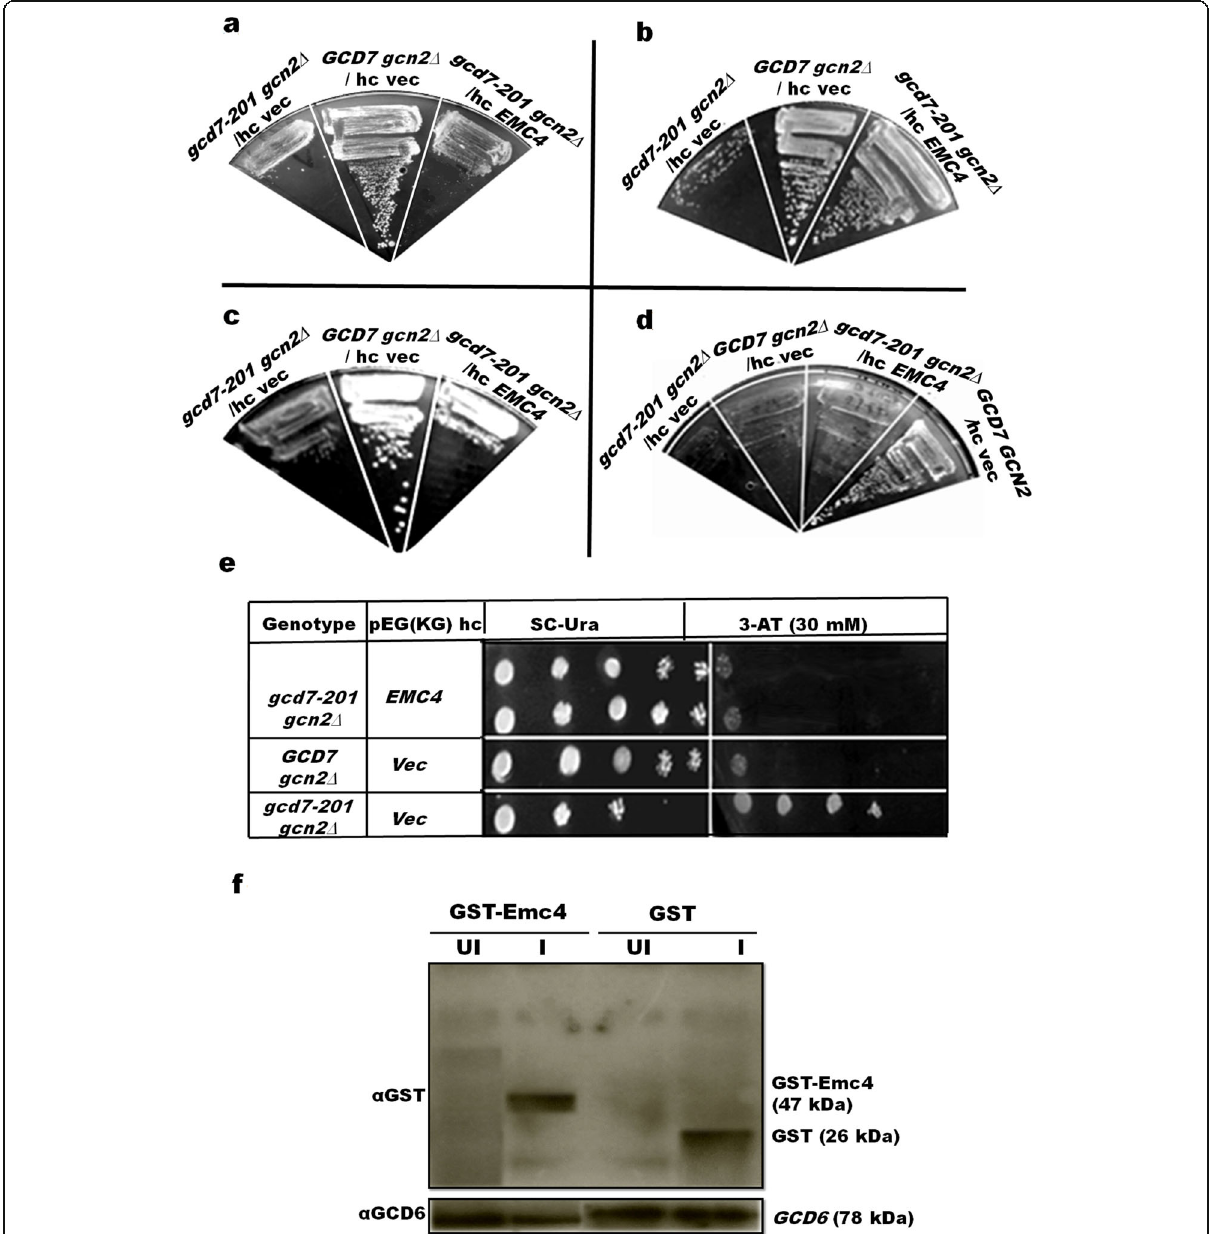
Fig. 1 S. cerevisiae gcd7-201 gcn2 Δ mutant strain confers Slg + and Gcd + phenotype when transformed with high copy (hc) pEG(KG)/ EMC4 plasmid. GCD7 gcn2 Δ , gcd7-201 gcn2 Δ harboring hc/ EMC4 , or empty hc vector pEG(KG) were streaked in parallel on SC medium lacking uracil, but either containing ( a ) raffinose or ( b ) galactose. Uracil-based plasmid hc/ EMC4 was evicted on SC medium containing ( c ) FOA, and were further streaked on ( d ) SC-Ura medium. ( e ) Spotting of GCD7 gcn2 Δ , gcd7-201 gcn2 Δ harboring hc/ EMC4 , or empty hc vector pEG(KG) was done on SC medium containing 2% galactose and lacking uracil or SC medium containing 2% galactose, 30 mM 3-AT, and lacking uracil. Plates were incubated at 30 °C for 2 days. ( f ) Western analysis of GST-Emc4p expression in gcd7-201 gcn2 Δ strain with anti-GST antibody. The whole cell protein extracts (20 μ g) were prepared from uninduced and 2% galactose-induced cultures of the strain harboring hc/ EMC4 . Samples were then separated on 10% SDS gel followed by Western blotting using anti-GST for GST-Emc4 and anti-Gcd6 antibodies (Loading control). UI, uninduced; I,